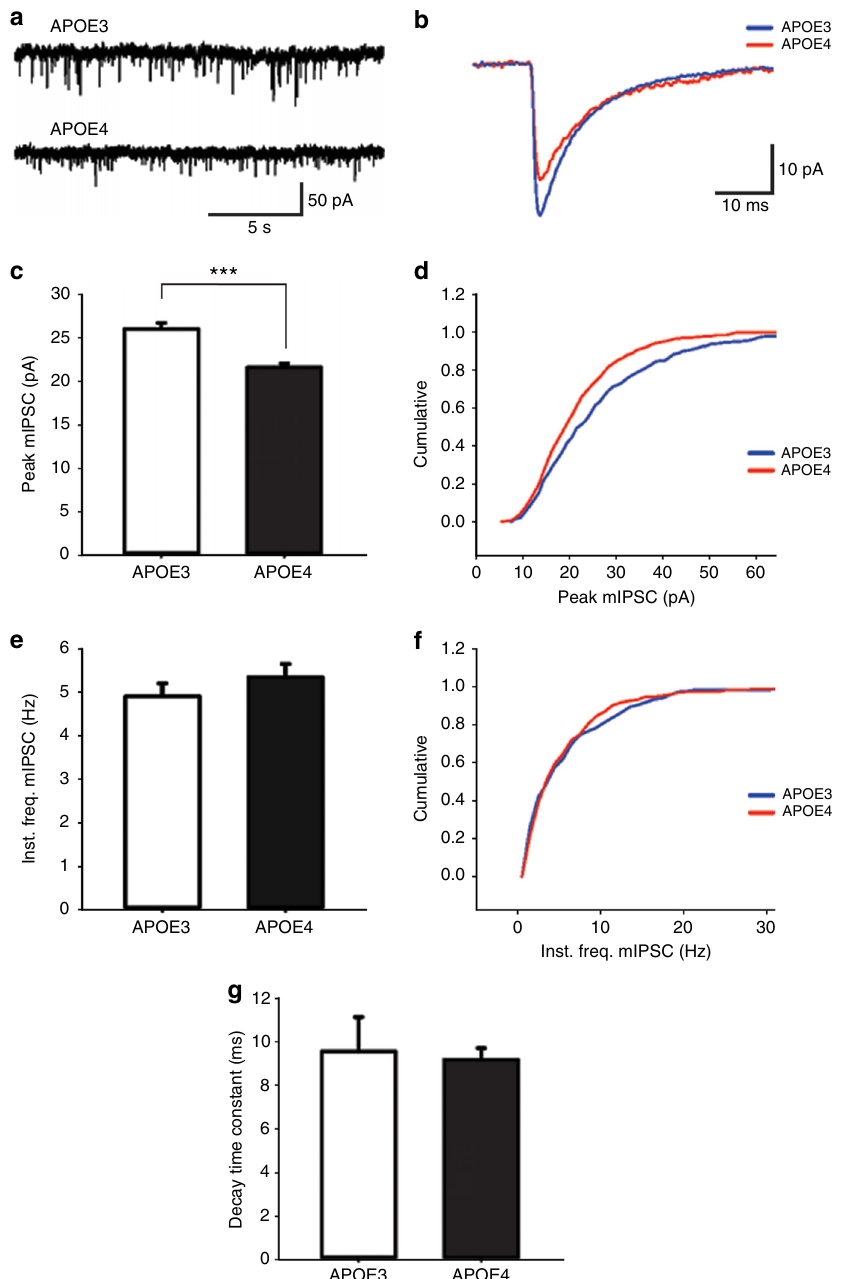
Fig. 5 APOE4 is associated with decreased background synaptic inhibition in layer II entorhinal cortex pyramidal neurons. Miniature inhibitory post-synaptic currents (mIPSCs) were recorded using the patch-clamp whole-cell modality on pyramidal cells ( n = 7 cells from APOE3 and n = 8 cells from APOE4 ) in the layer II EC of aged APOE mice (mean age = 20 months). a Representative traces of mIPSCs of layer II EC pyramidal neurons of APOE3 and APOE4 mice from recordings in voltage-clamp modality (holding at − 65 mV) in the presence of APV (10 µ M), NBQX (16 µ M), and TTX (1 µ M). b Representative average mIPSCs from a 3 min recording of an APOE3 and APOE4 mouse. c Plotted are mean + SEM values of peak amplitude of mIPSCs in the different genotypes as indicated ( APOE3 26.09 ± 0.73 pA; A POE4 21.6 ± 0.48 pA; p < 0.001). d Cumulative probability distribution of peak amplitude in APOE3 and APOE4 mice, showing lower values for APOE4 in the entire distribution. e Shown are mean + SEM values of instantaneous frequencies in the different genotypes ( APOE3 4.92 ± 0.3 Hz; APOE4 5.36 ± 0.31 Hz; t (748) = − 1.035, p = 0.301). f Cumulative probability distribution of instantaneous frequencies in APOE3 and APOE4 mice, showing no signi fi cant differences. g Plotted are mean + SEM values of decay time constant in both groups ( APOE3 9.56 ± 1.61 ms; APOE4 9.19 ± 0.53; p = 0.819). (*** p <